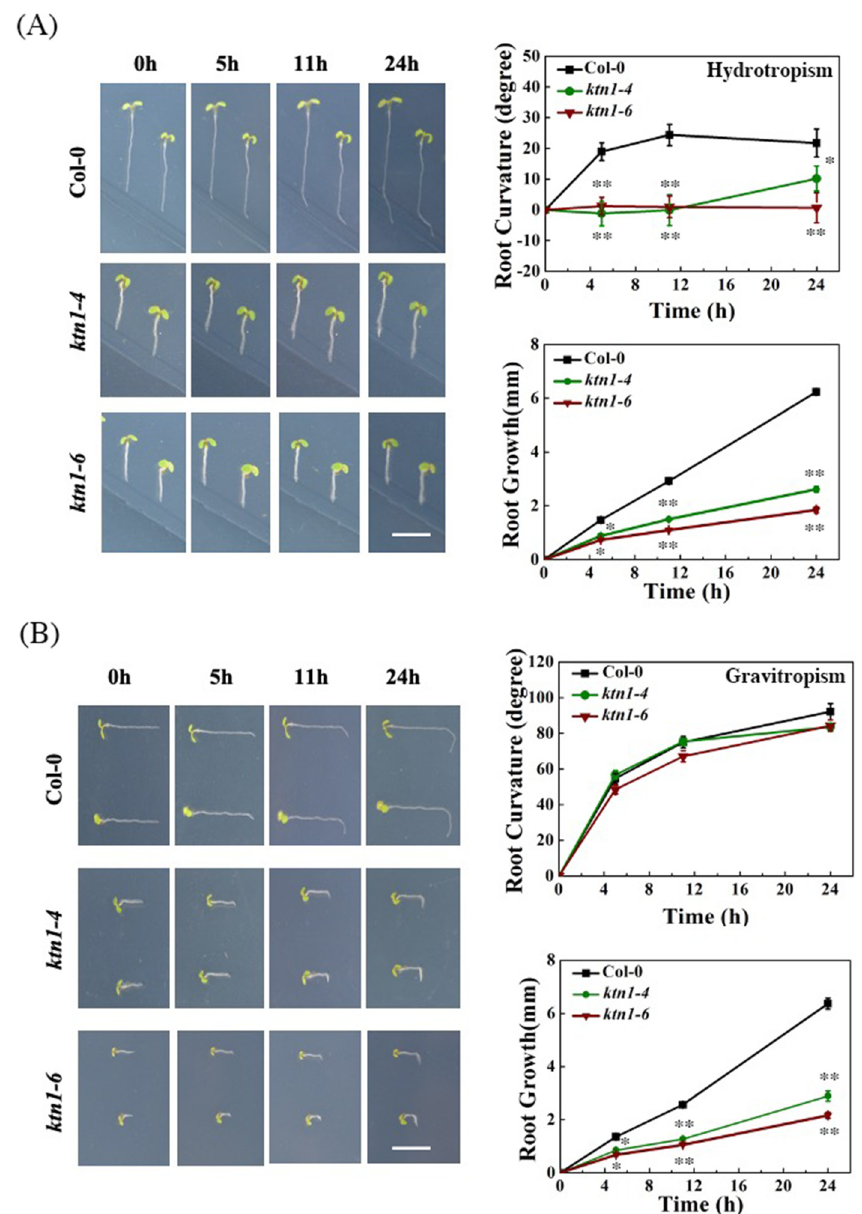
Figure 2. Arabidopsis KATANIN mutants ( ktn1 ) show reduced root hydrotropism. ( A ) Measurements of root curvatures and growth rates of ktn1-4 and ktn1-6 mutants after hydrostimulation treatment for 0, 11, and 25 h. ( B ) Measurements of root curvatures and growth rates of ktn1-4 and ktn1-6 mutant after gravistimulation treatment for 0, 11, and 25 h. Scale bar = 1 cm. Error bars indicate the SE; n ≥ 36. Asterisks show significant difference from the wild type at * p < 0.05 or ** p < 0.01 (Student’s t -test).